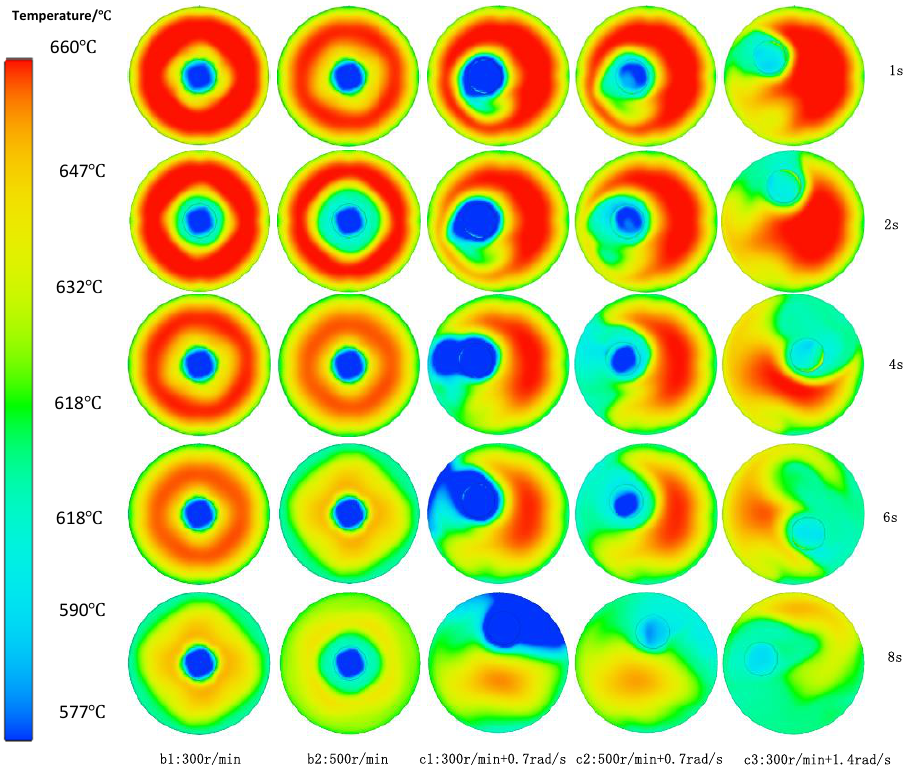
Figure 4. Variation of melt temperature field in planetary mixing stirring